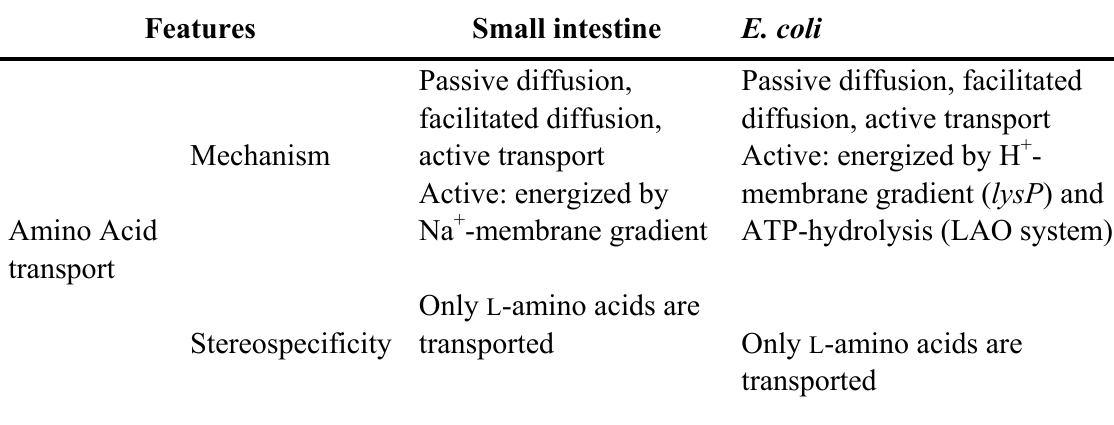
Table 3. Comparison between lysine assimilation by small intestine and E. Coli